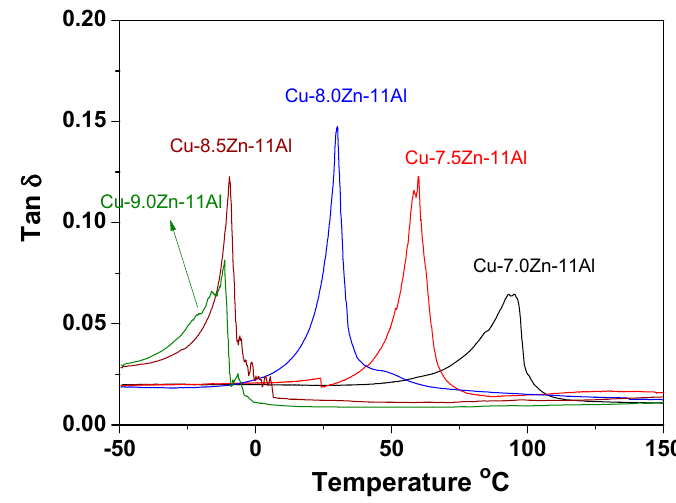
Figure 4. DMA tan δ curves measured at 1 Hz and 3 °C·min − 1 cooling rate for Cu-xZn-11Al SMAs with various Zn contents.